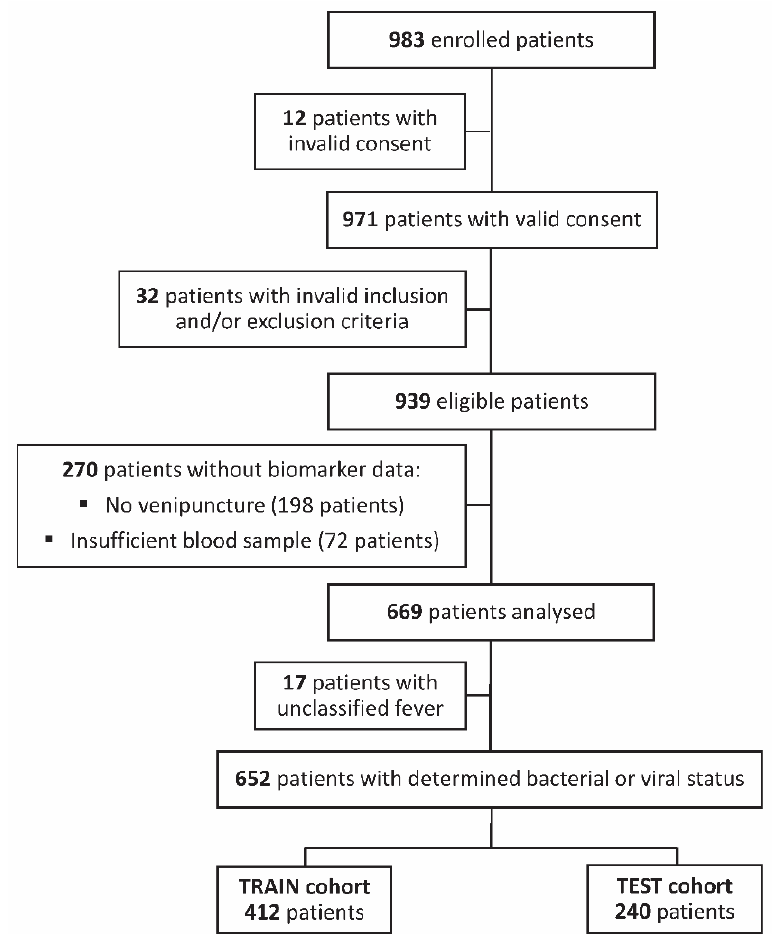
Figure 1. Study flow diagram. Out of 983 enrolled paediatric patients, 12 were ineligible due to invalid informed consent and 32 due to invalid inclusion and/or exclusion criteria. Out of the 939 eligible patients, 270 patients with missing biomarker data due to sampling failure were excluded from the analysis. Out of 669 analysed patients, 17 with indeterminate infection status (unclassified fever) were excluded from computational modelling. Altogether, 652 patients with a determined infection status were partitioned into a training (TRAIN) cohort ( n = 412) and an independent validation (TEST) cohort ( n = 240).